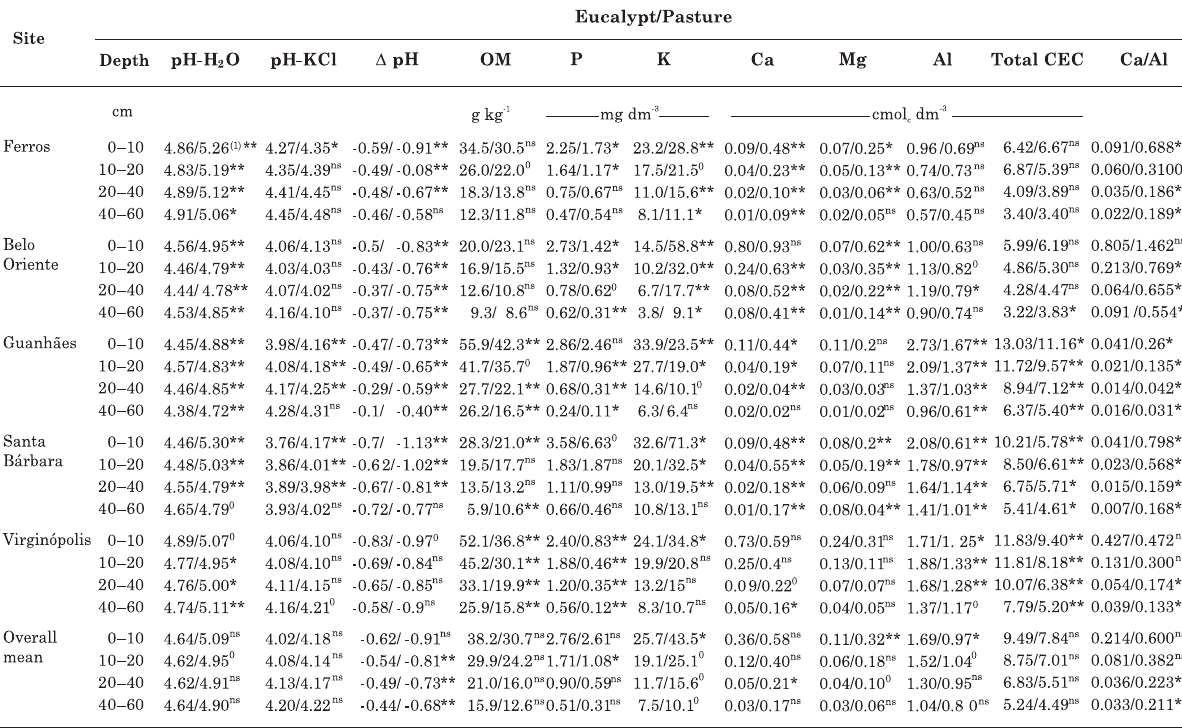
Table 2. Chemical properties of soils under eucalyptus/pasture areas at different depths in five regions in the Rio Doce